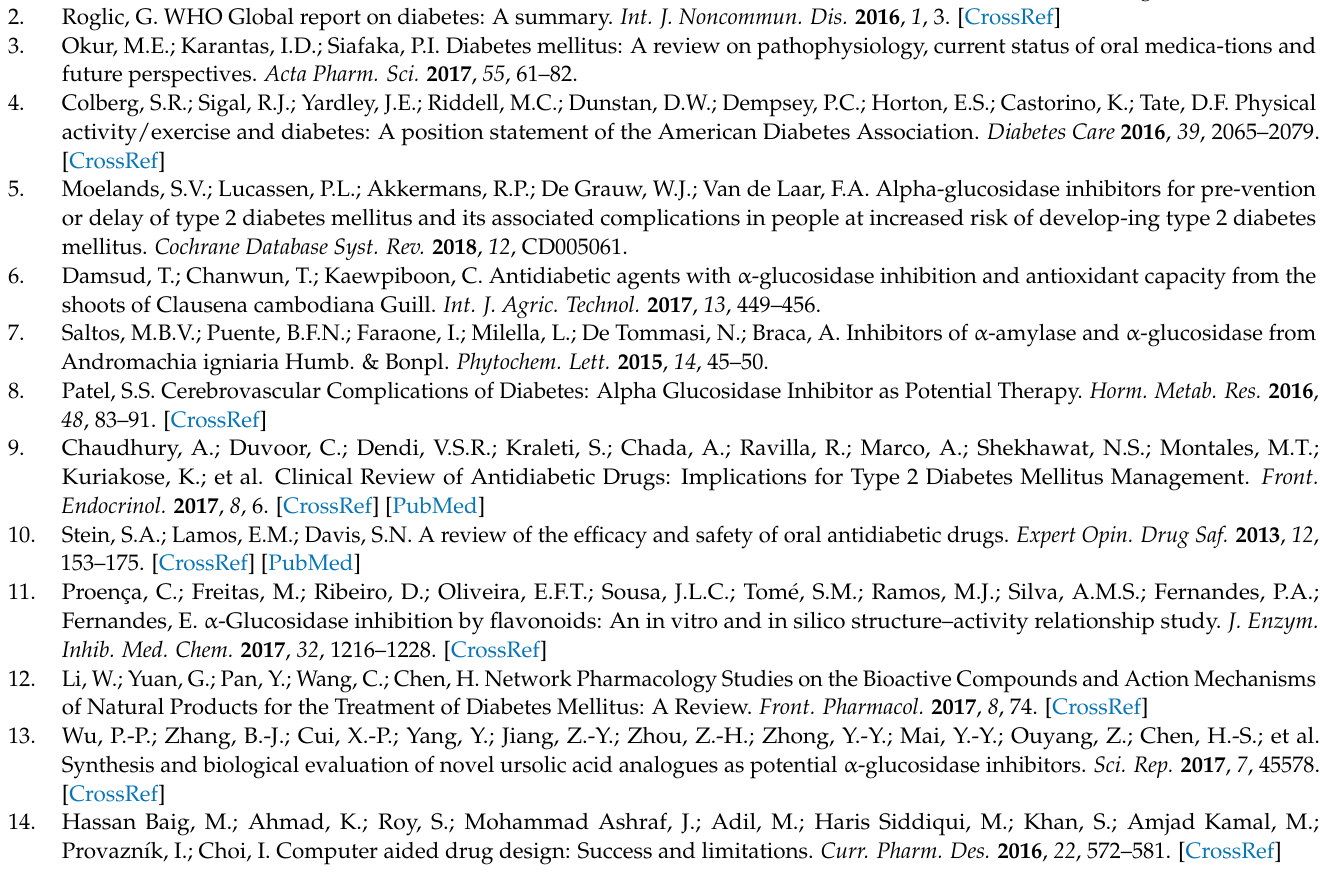
S. cerevisiae α -glucosidase model and templates, Figure S2: Receiver Operating Curve (ROC) for α -glucosidase obtained from MOE, Figure S3: correlation of inhibitory activities of known inhibitors with their docking score, Table S1: ADMET Properties of Selected 142 Hits, Table S2: Docking scores, docking ranks and protein-ligand interactions of 142 Hits, Table S3: 3D-structures of selected hits, Table S4: The predicted activities of thirty-two compounds (Test set 2), Figure S4: The correlation plot of Test set